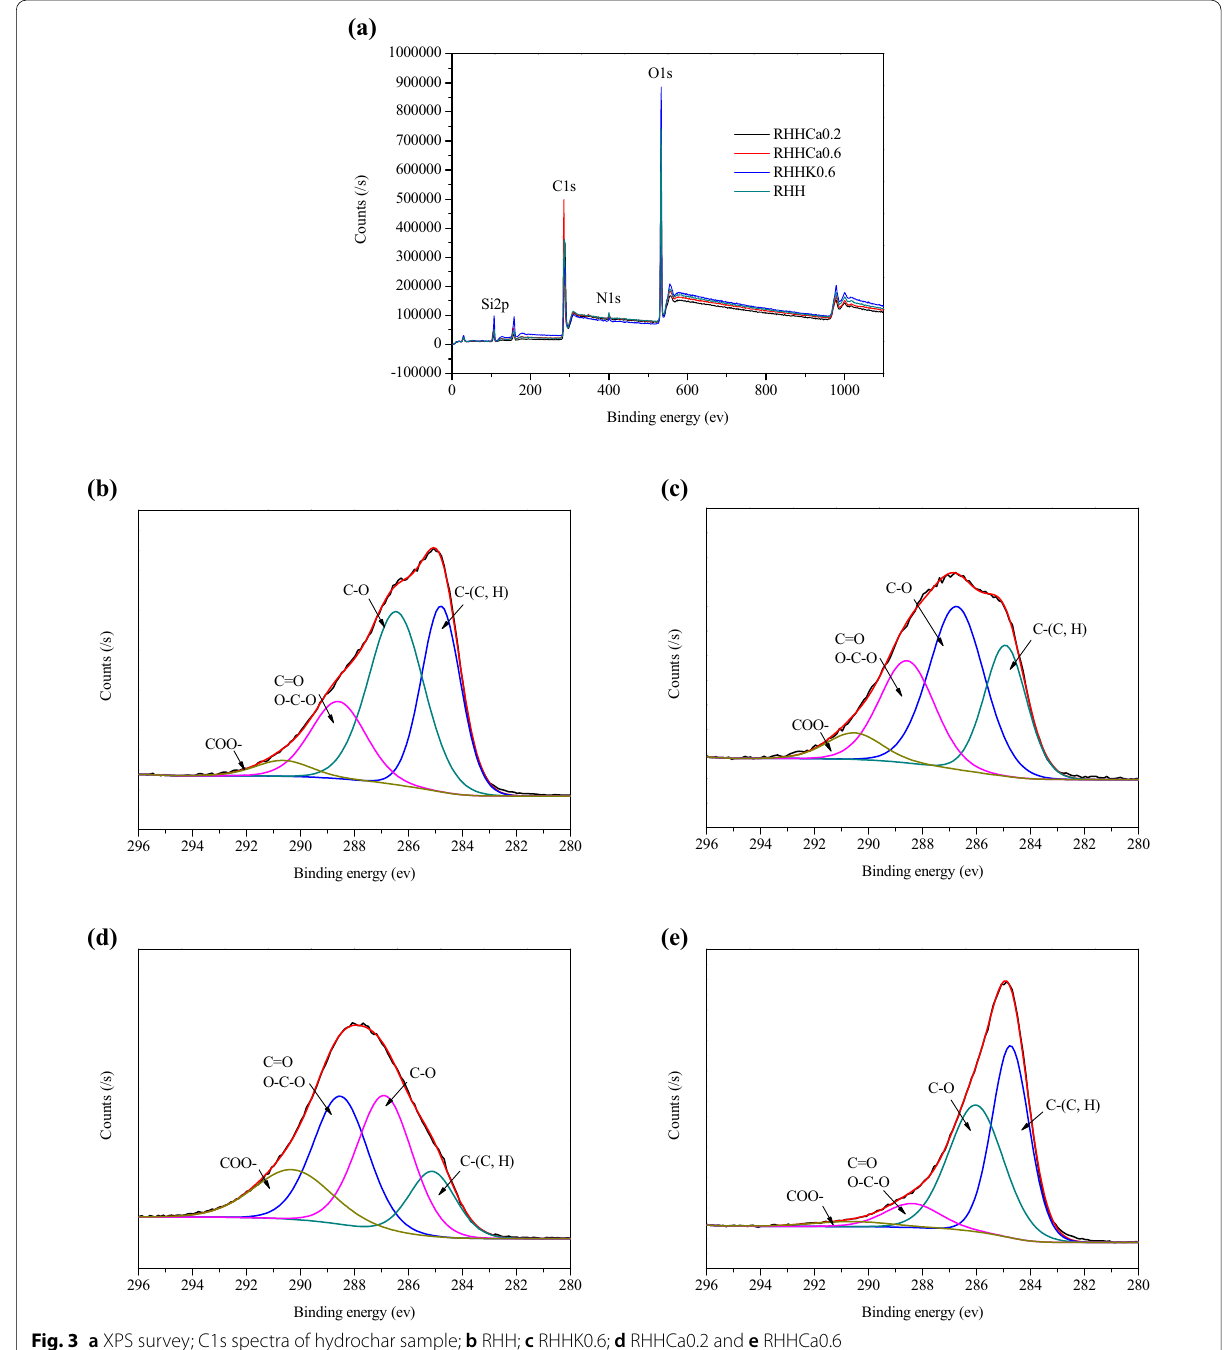
Fig. 3 a XPS survey; C1s spectra of hydrochar sample; b RHH; c RHHK0.6; d RHHCa0.2 and e